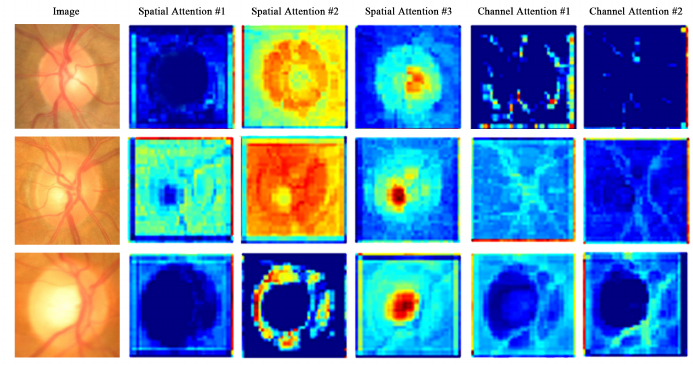
Figure 6. Examples of the two attention blocks. Column 1: input image, Column 2, 3 and 4: the maps of spatial attention block, Column 4 and 5: the maps of channel attention